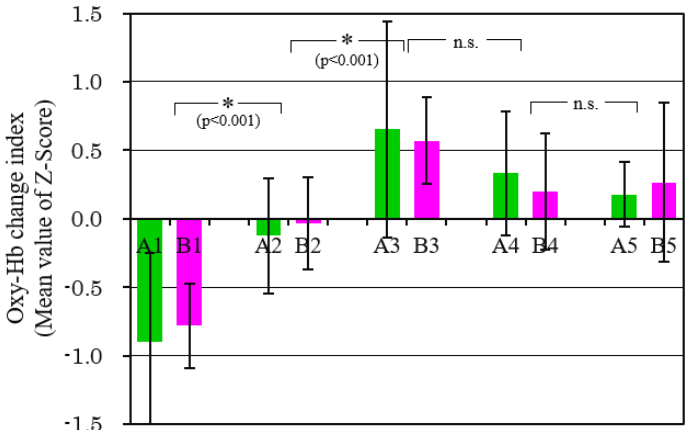
Figure 12. Comparison of Oxy-Hb change index in each scene. (Data of channels 4, 10, 13, and 19 was used).